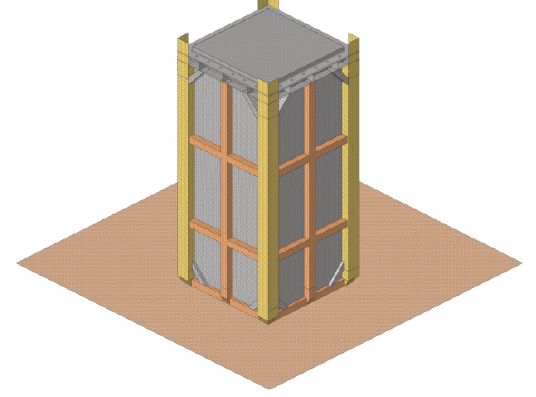
Figure 6. The FE model of the SFE canister.